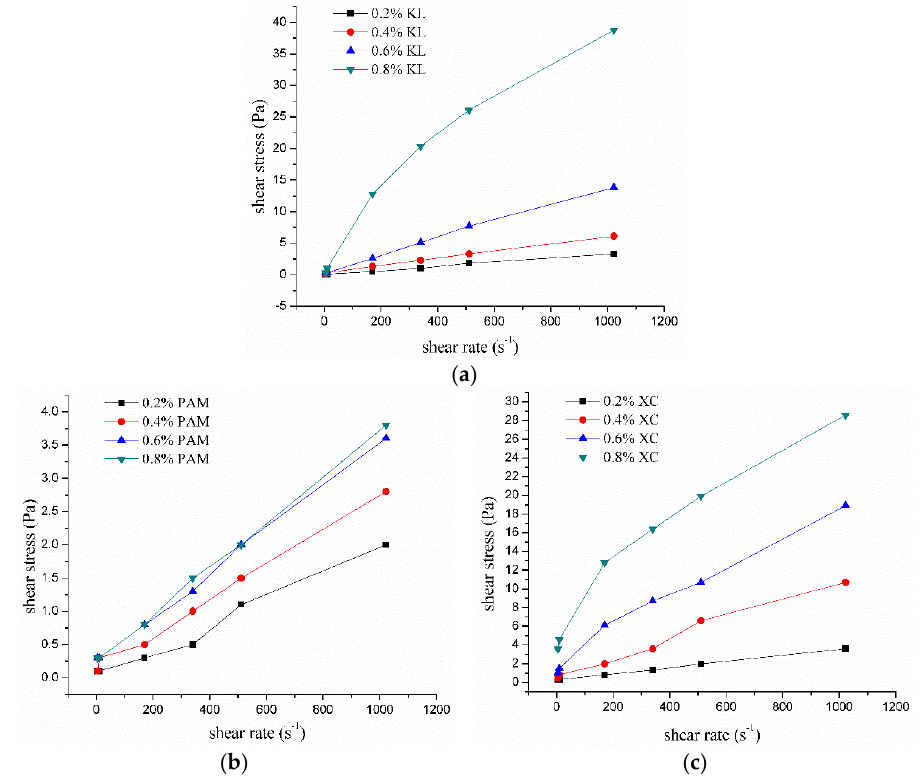
Figure 1. Shear stress with shear rate curves of different concentrations of Semen Lepidii natural vegetable gum (KL), polyacrylamide (PAM), and xanthan gum (XC) drilling fluids. ( a ) KL drilling fluid rheological curve; ( b ) PAM drilling fluid rheological curve; and ( c ) XC drilling fluid rheological curve.